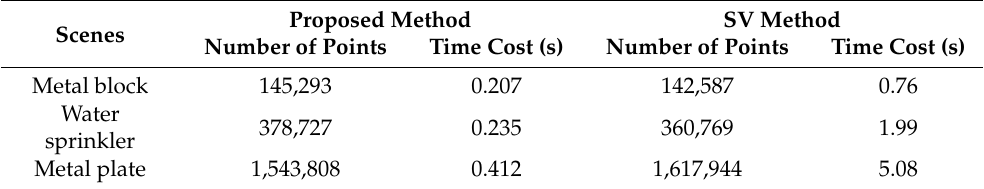
Figure 10. The captured fringe images of different objects: ( a ) a stepped metal block, ( b ) a water sprinkler part, ( c ) a metal plate, ( d ) the measurement result of ( a ), ( e ) the measurement result of ( b ), and ( f ) the measurement result of ( c ). Table 3. Data related to the efficiency of 3D reconstruction.